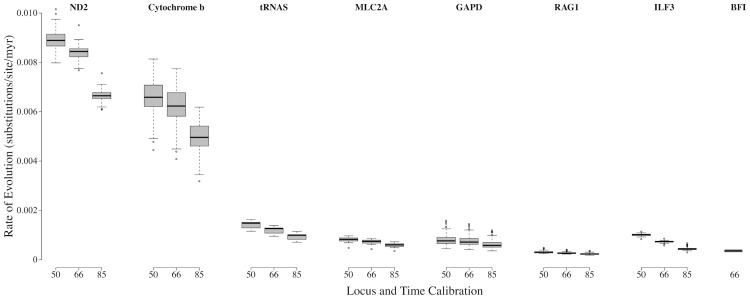
Box plot depicting the estimated rates of evolution of each study locus.Each box plot contains the estimates of evolutionary rate at each node and tip of the tree. The bottom and top of the box delimit the first and third quartiles, respectively, and whiskers extend to a maximum of 1.5 times the interquartile range. Asterisks indicate outlier points.